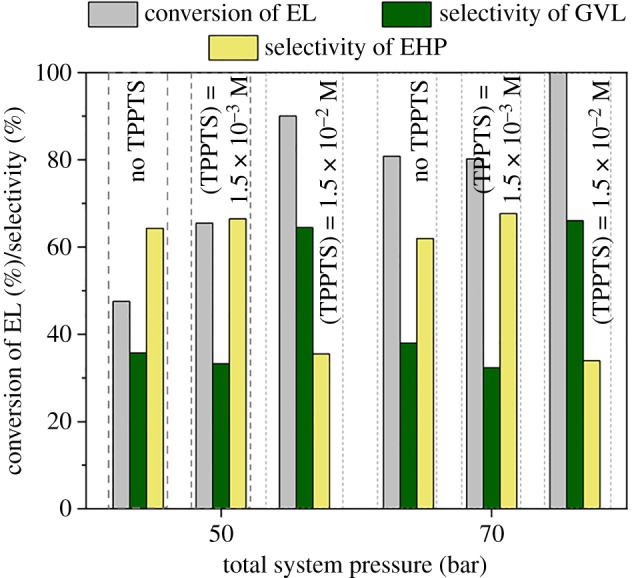
Effect of ligand concentration on conversion of EL to GVL in water. Conditions: Csubstr = 0.1 M, flow rate = 1 ml min–1, T = 100°C.